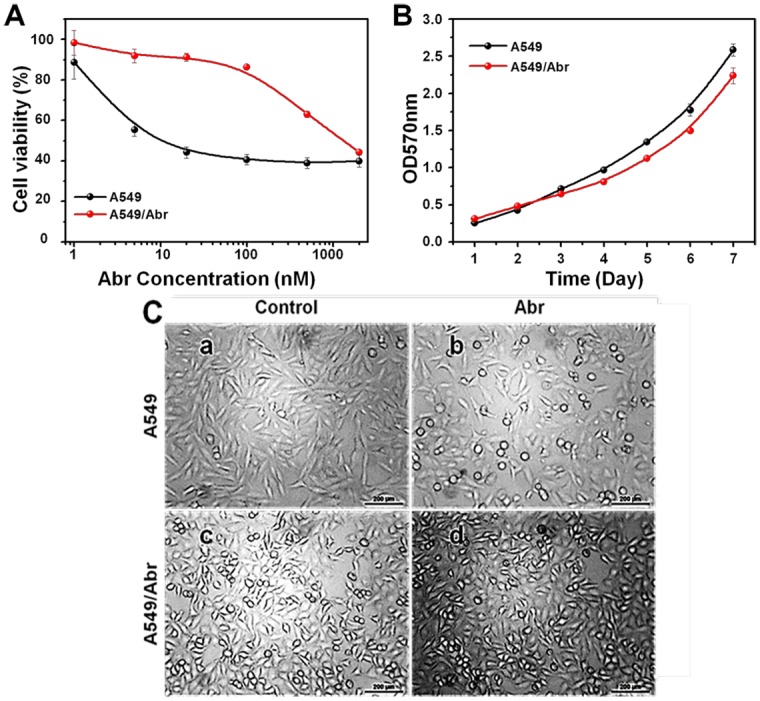
Establishment of Abraxane-resistant NSCLC cell line.(A) The A549/Abr cell line is resistant to Abraxane. A549 (•, black) and A549/Abr (•, red) cells were treated with the indicated increasing concentrations of Abraxane for 48 h. Cell viability was detected using MTT assay. Each point represents the mean±SD of three measurements. IC50 is the concentration of Abraxane that inhibits 50% of cell proliferation. The IC50 values for the A549 and A549/Abr cells were 11.07 nM and 1314.66 nM, respectively. (B) Growth curves of both cell lines, A549 (black dots) and A549/Abr (red dots). The curves of Abr-resistant cells rise up slowly. The doubling time of A549 cells is 49.56 h and that of A549/Abr cells is 54.65 h. (C) Morphological comparison of A549 cell line and A549/Abr cell line. Effects of Abraxane on the morphologic changes in A549 and A549/Abr cells. Cells were treated with (b and d) or without (a and c) 100 nM Abraxane for 24 h and the morphologic changes were observed by microscopy.